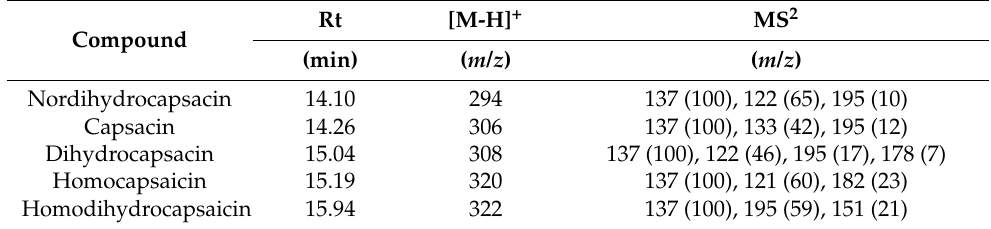
Table 2. Identification of individual capsaicinoids.